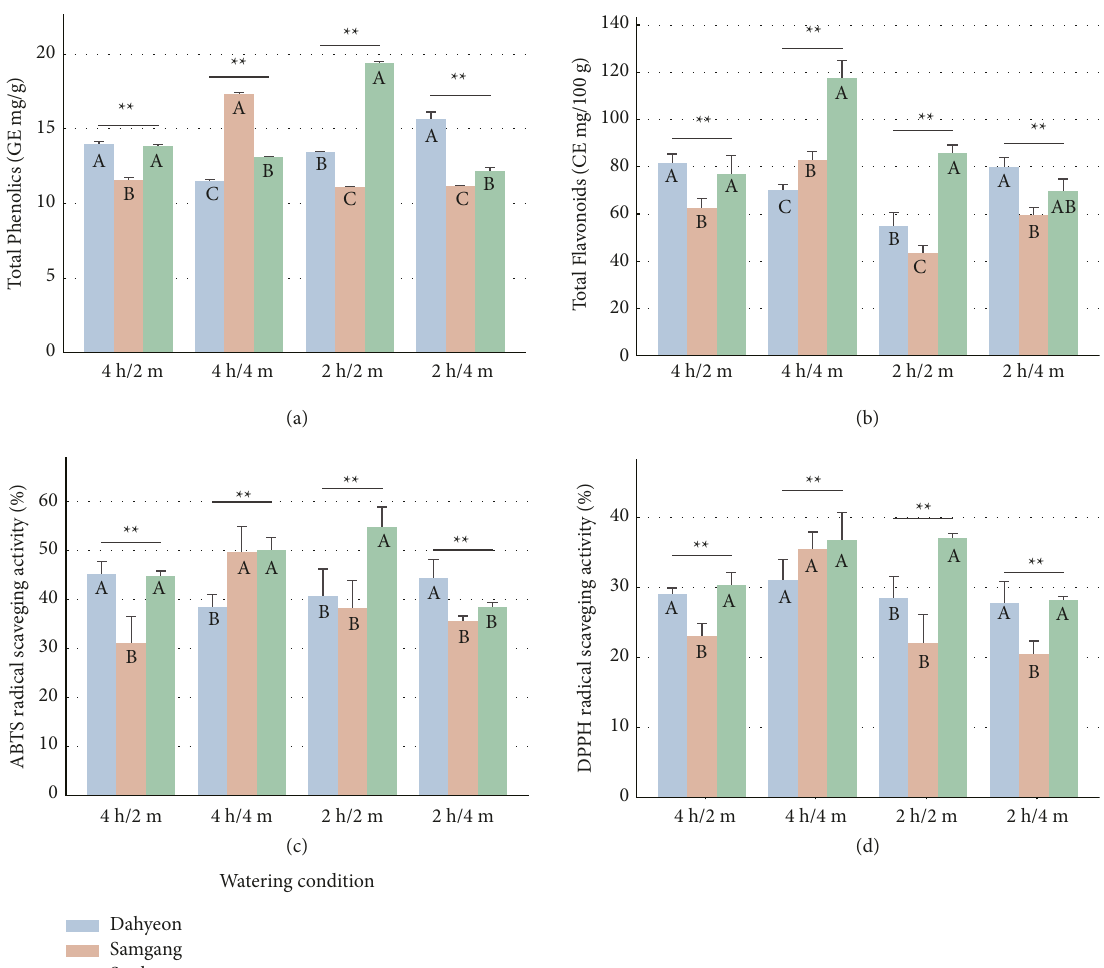
Figure 3: Comparison of (a) total phenolic contents, (b) total flavonoid contents, (c) antioxidant scavenging activity of ABTS, and (d) antioxidant scavenging activity of DPPH in three mung bean cultivars cultivated on different watering conditions. The comparison was conducted using mung bean sprouts after day 3 germination. The results were expressed with a standard error bar, and different lowercase letters indicate statistical significance ( P < 0 . 05). The asterisks indicate P value of statistical significance ( P < 0 . 05 ∗ , P < 0 . 01 ∗∗ , P < 0 . 001 ∗∗∗